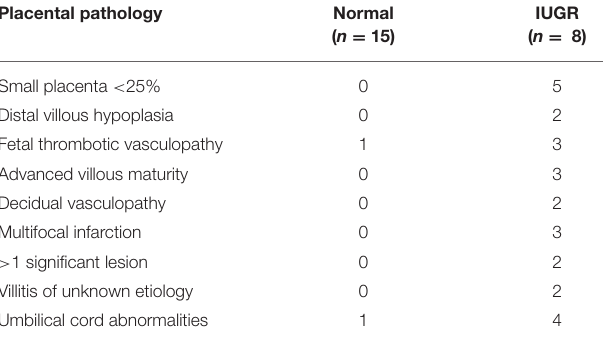
TABLE 2 | Placental histopathology in cases and